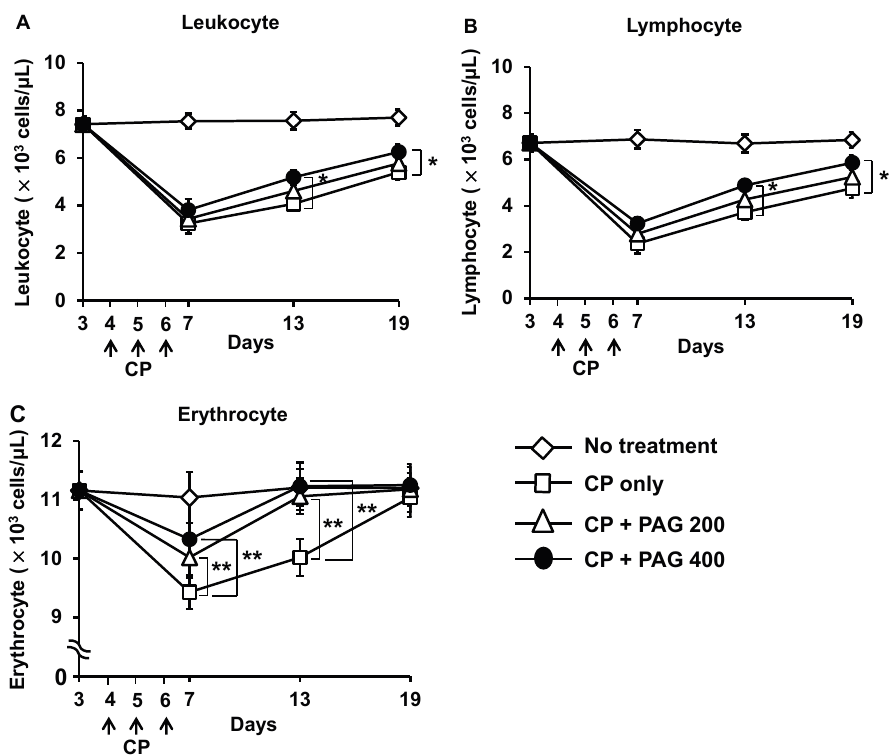
Figure 2. Oral administration of PAG prevents and restores CP-induced lymphopenia and erythropenia. Mice ( n = 10) were orally administered 200 or 400 mg/kg/day PAG for 19 days. Immunosuppression was induced by intraperitoneal (i.p.) injection of CP (25 mg/kg/day) for three consecutive days starting on the fourth day after PAG administration. The changes in the total numbers of leukocytes ( A ); lymphocytes ( B ); and erythrocytes ( C ) in the blood were examined on the indicated days. * indicates p < 0.05 and ** indicates p <